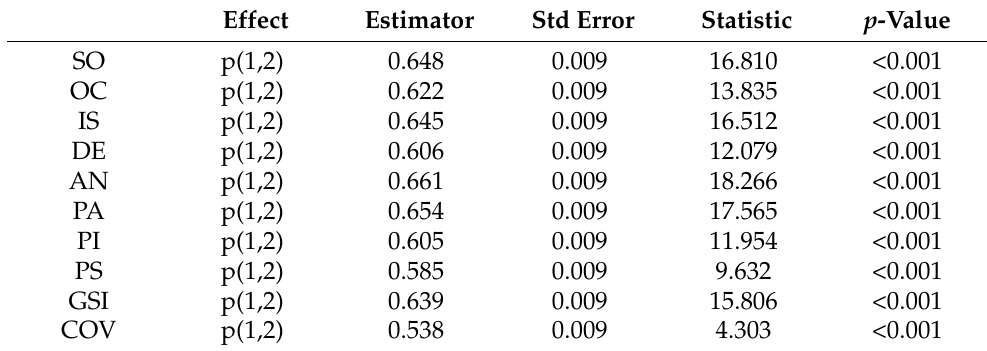
Table 4. Psychological distress differences by gender.